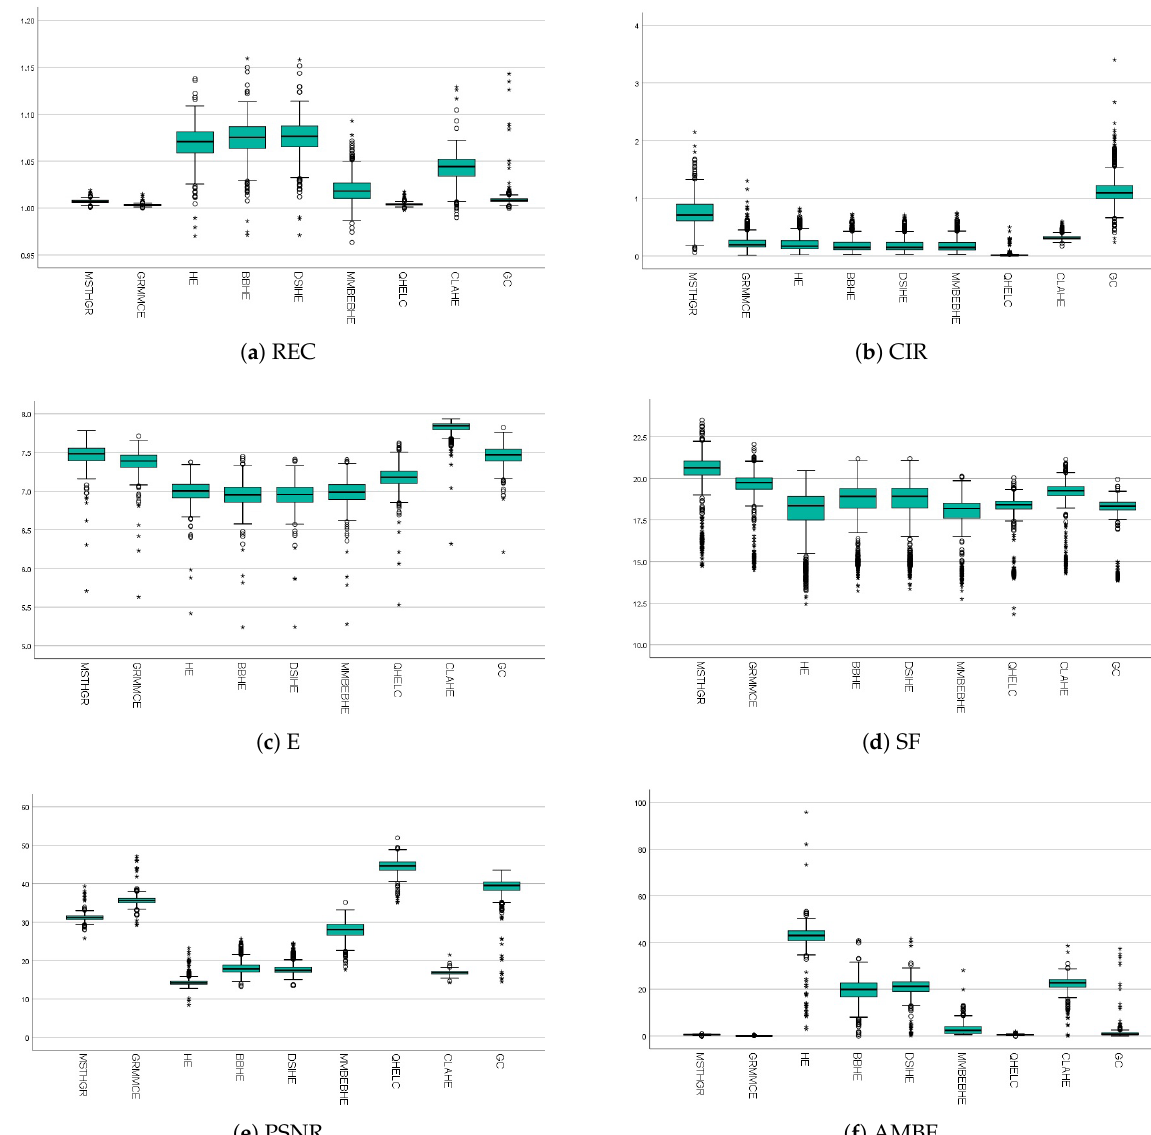
Figure 6. Box plots of the results obtained by the